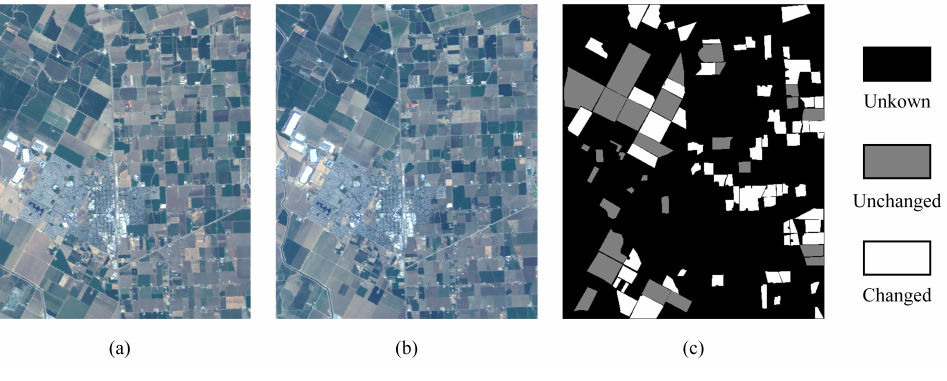
Figure 3. The Bay Area dataset. ( a ) Image acquired in 2013. ( b ) Image acquired in 2015. ( c ) Reference